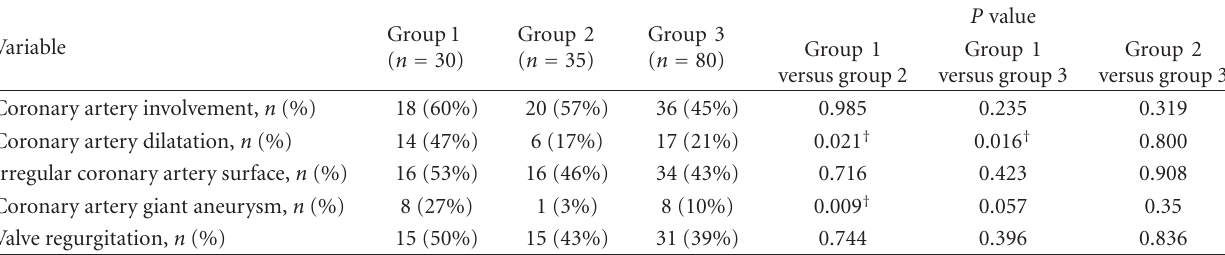
Table 3: Echocardiography